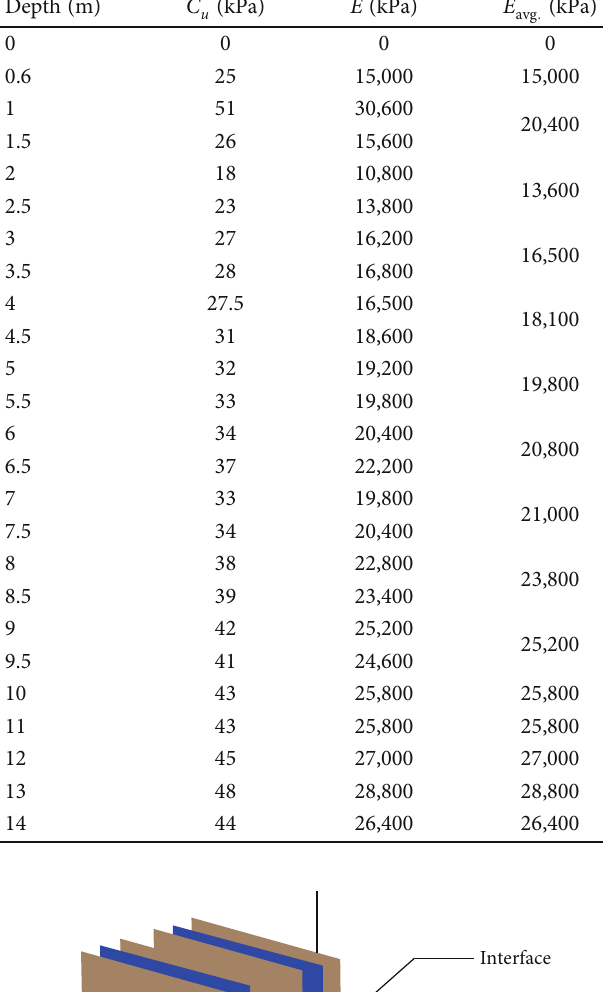
Table 4: Seasonal water head variation readings (data adapted from Laval University).